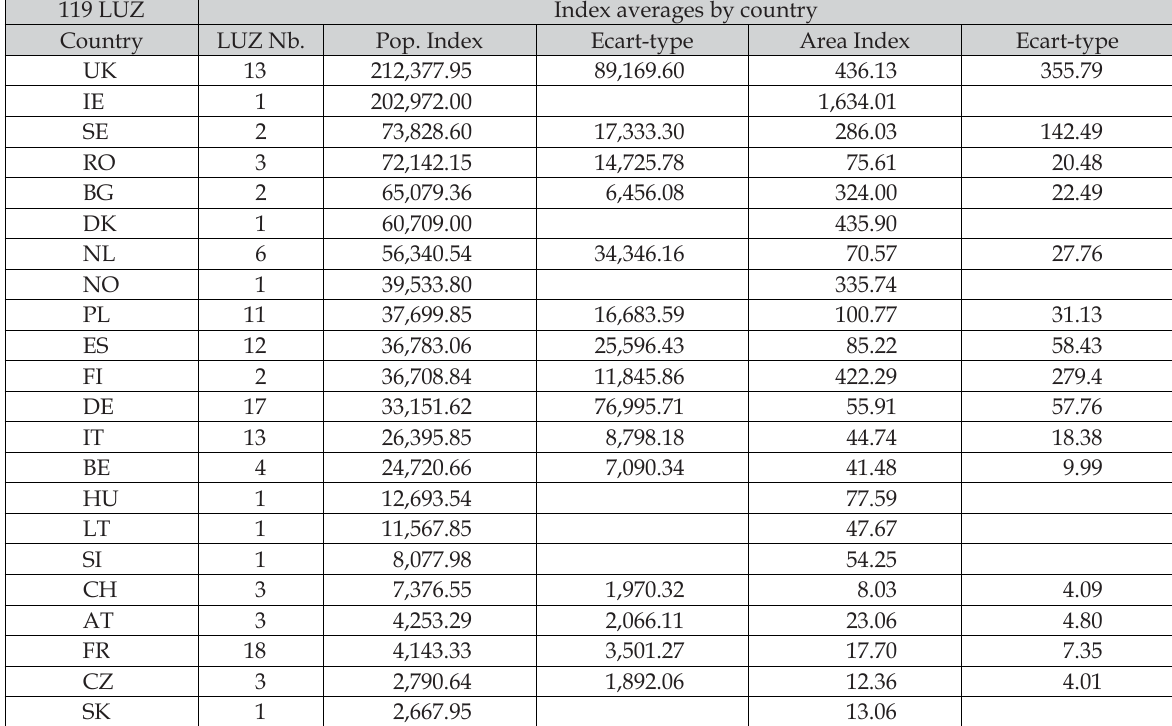
Table 4. Indicators by